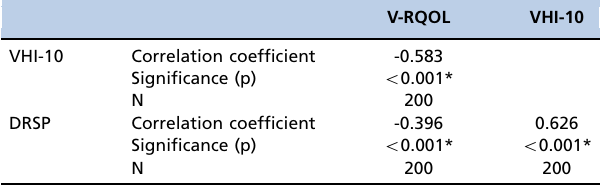
Table 5 - Correlation between the V-RQOL, VHI-10, and DRSP.